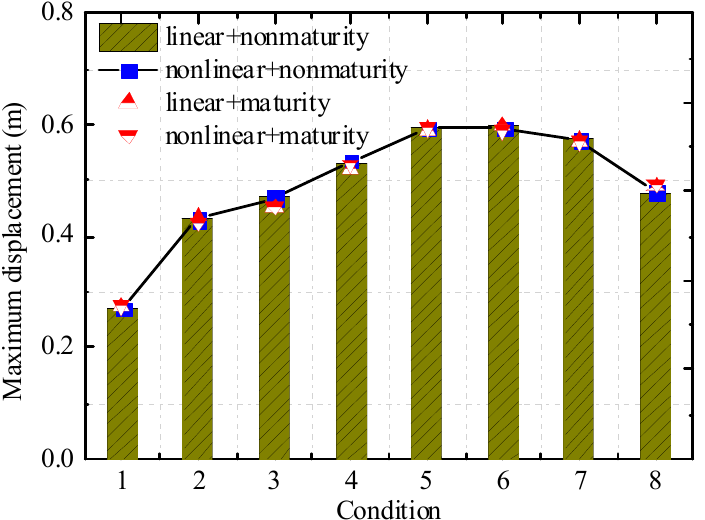
Figure 15. Comparison of maximum displacement under linearity and non-linearity of the structure for critical wind speed of buckling during the whole construction process.